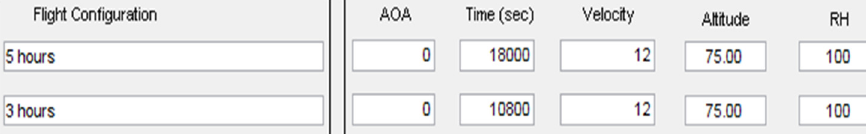
Figure 5. LewInt atmospheric configuration.